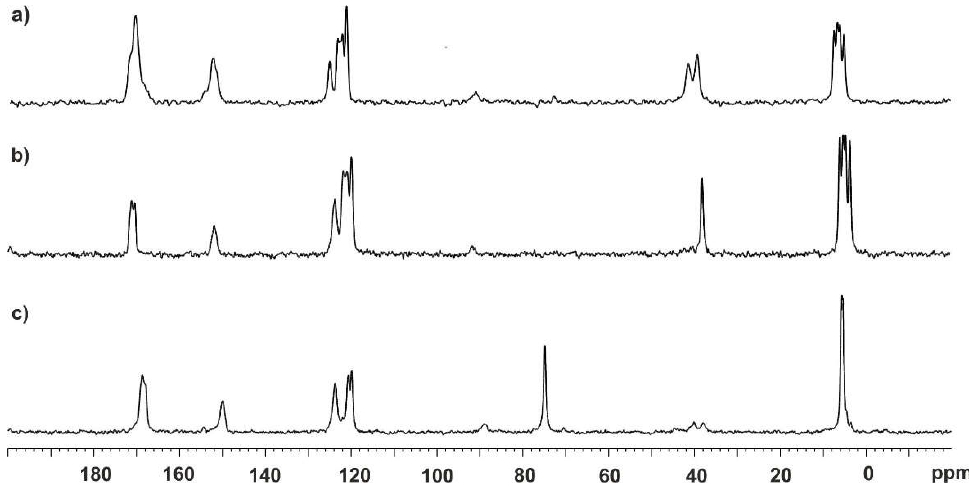
Figure 8. 13 C CP/MAS Spectra recorded with a spinning rate of 8 kHz for (a) physical mixture of HIMO Figure 8. 13 C CP / MAS Spectra recorded with a spinning rate of 8 kHz for ( a ) physical mixture of HIMO and BA (II) in a ratio of 1:1; (b) physical mixture of HIMO and BA-dihydrate in a ratio of 1:1; (c) HIMO and BA (II) in a ratio of 1:1; ( b ) physical mixture of HIMO and BA-dihydrate in a ratio of 1:1; ( c ) HIMO and BA in a ratio of 1:1 after 2 h of grinding employing MeOH as LAG. and BA in a ratio of 1:1 after 2 h of grinding employing MeOH as